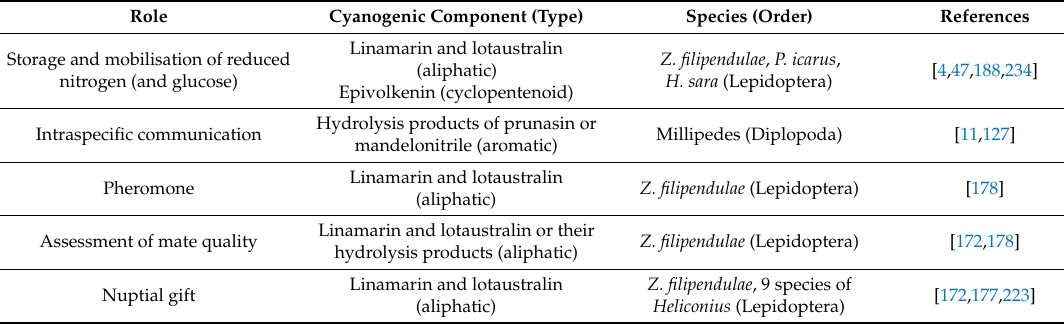
Table 2. Roles of CNglcs apart from defence in